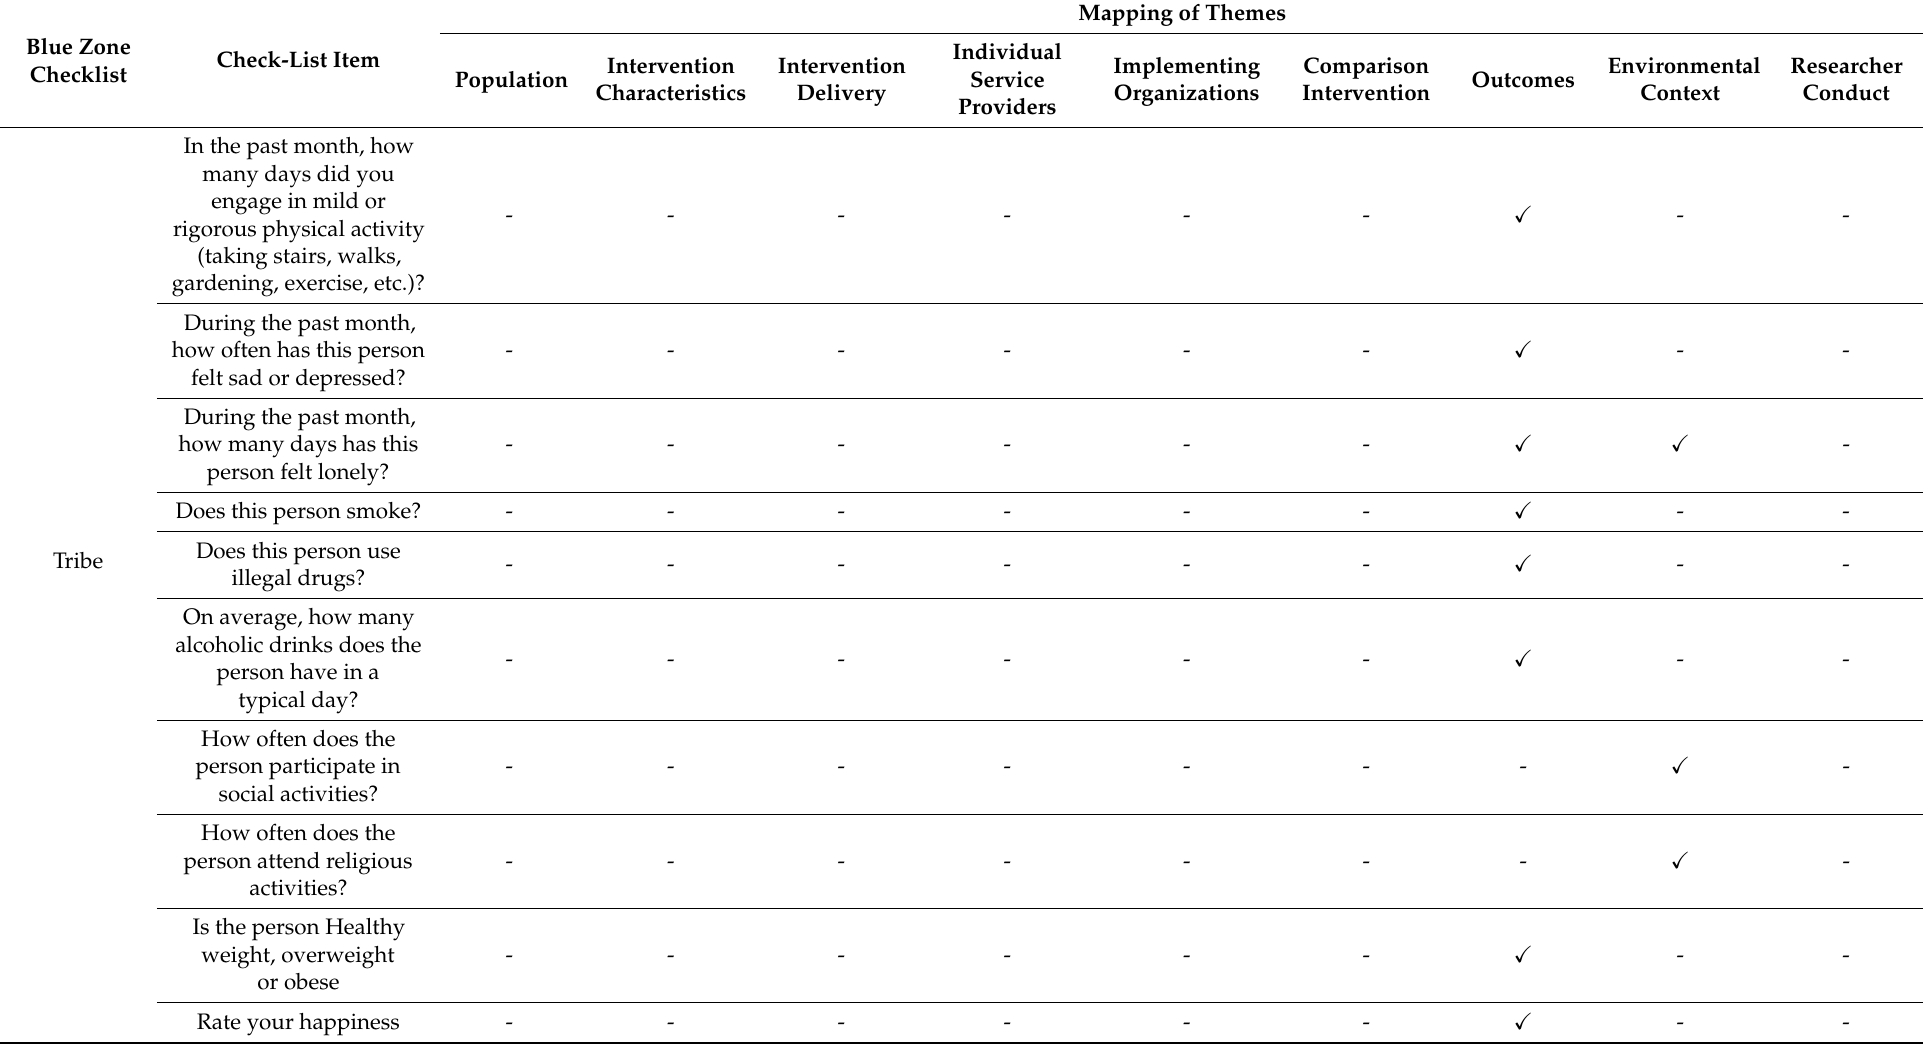
Table 11. Critical review of the “Tribe” checklist based on the systematic mapping by Munthe-Kaas et al. [60].